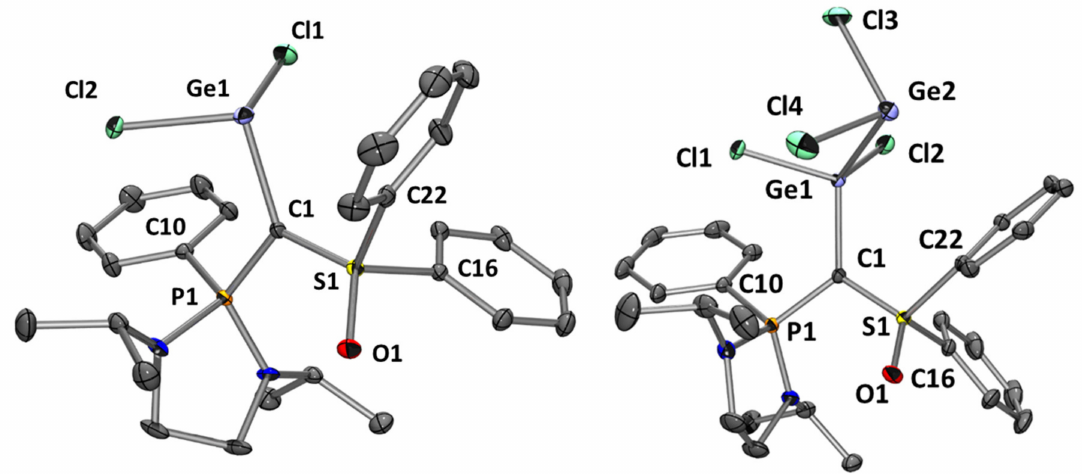
Figure 2. Molecular structures of 5 ( left ) and 6 ( right ). Ellipsoids are drawn at the 30% probability level; hydrogen atoms are omitted for clarity. Selected bond lengths (Å) and angles ( ◦ ): 5 : C1-Ge1 2.071(2), C1-P1 1.725(2), C1-S1 1.650(2), P1-C10 1.802(3), S1-O1 1.457(2), Ge1-Cl2 2.299(1), Ge1-Cl1 2.331(1), S1-C22 1.780(3), S1-C16 1.784(3). P1-C1-S1 113.73(14), P1-C1-Ge1 128.12(13), Ge1-C1-S1 115.65(13), C1-Ge1-Cl2 96.82(7), Cl2-Ge1-Cl1 95.37(3), Cl1-Ge1-C1 98.81(7); 6 : C1-Ge1 1.980(2), C1-P1